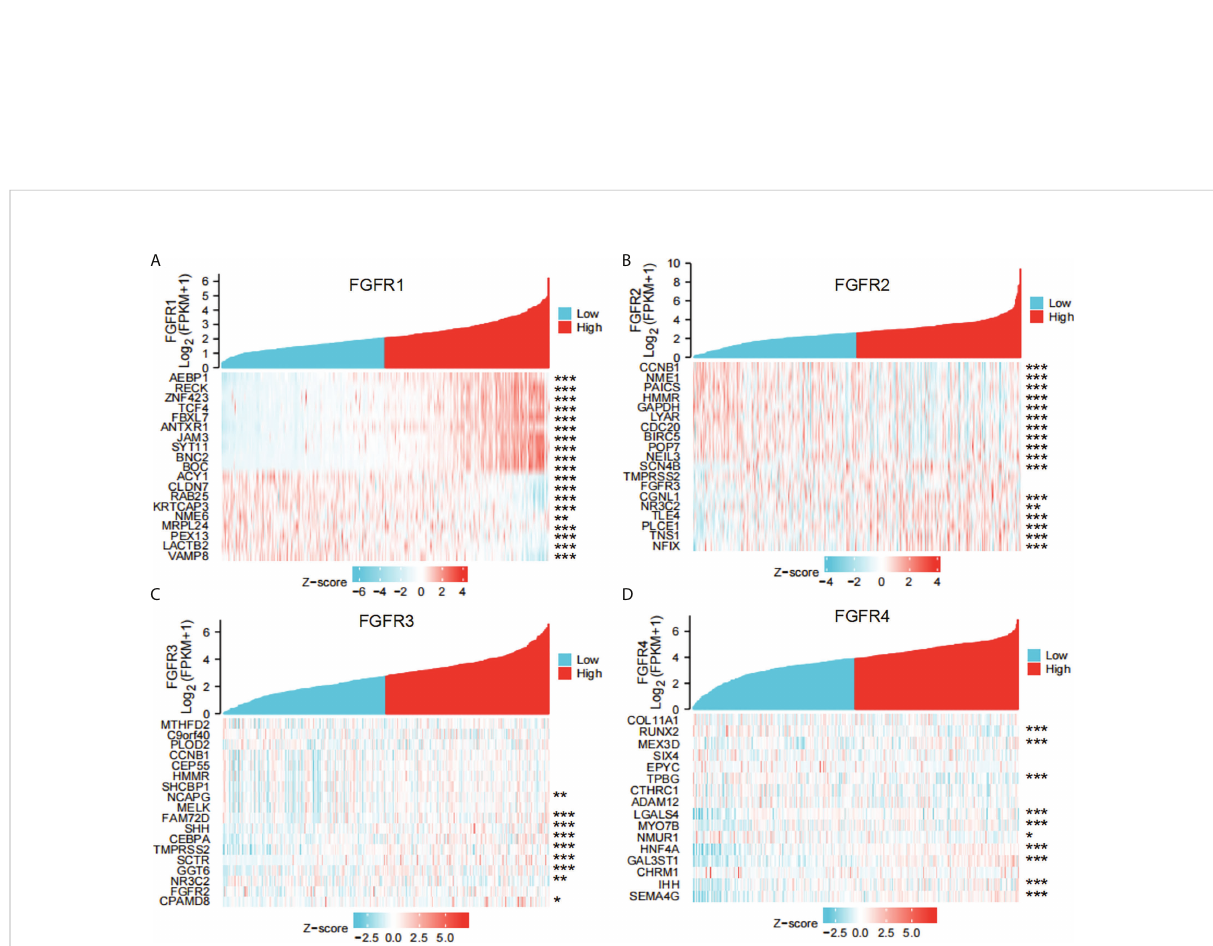
FIGURE 3 The co-expressed genes associated with the expression of FGFRs were analyzed as a heatmap by using the STAD data sets of TCGA. (A) FGFR1, (B) FGFR2, (C) FGFR3, (D) FGFR4. * p <0.05; ** p <0.01; *** p